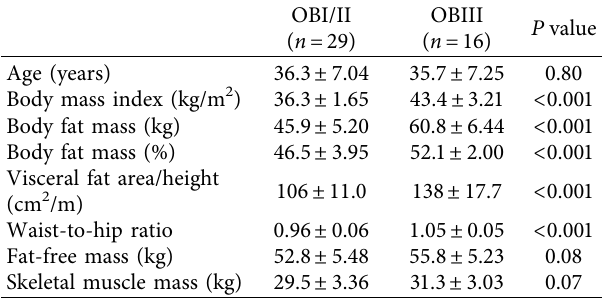
Table 1: Body composition of study participants.